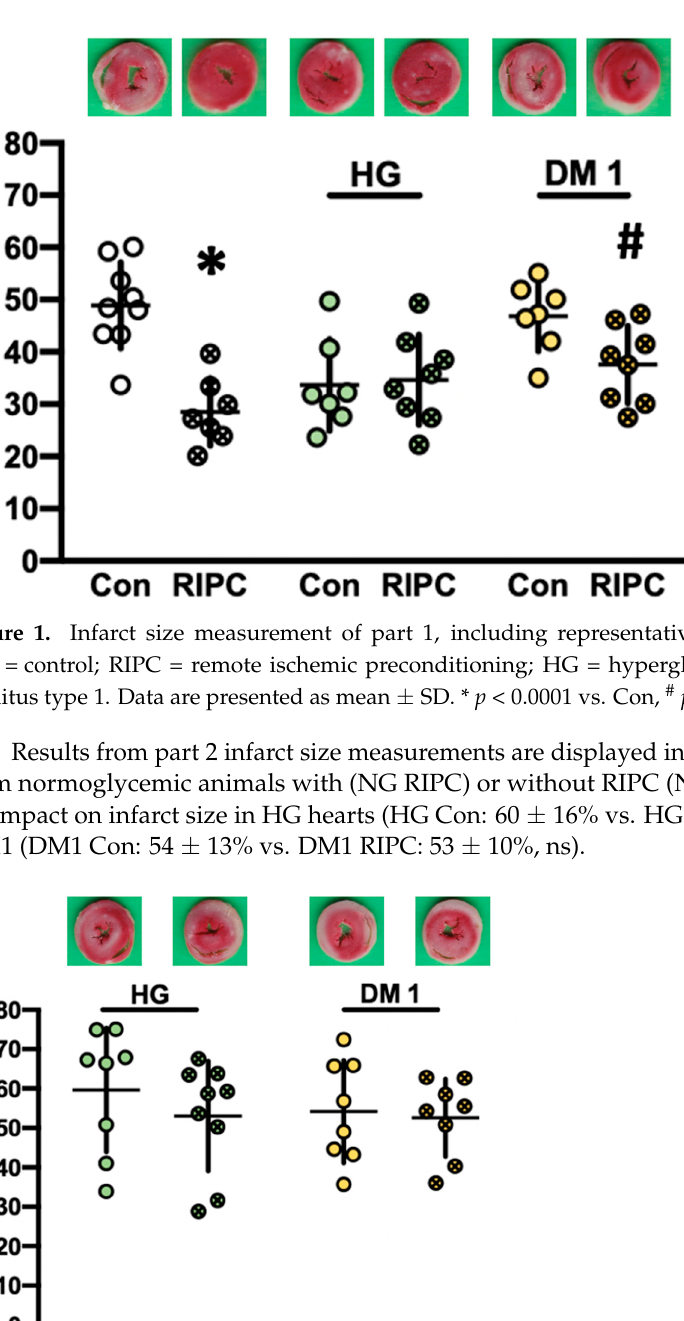
Table 2. Hemodynamic variables from part 1 (plasma transfer diseased → healthy). Baseline